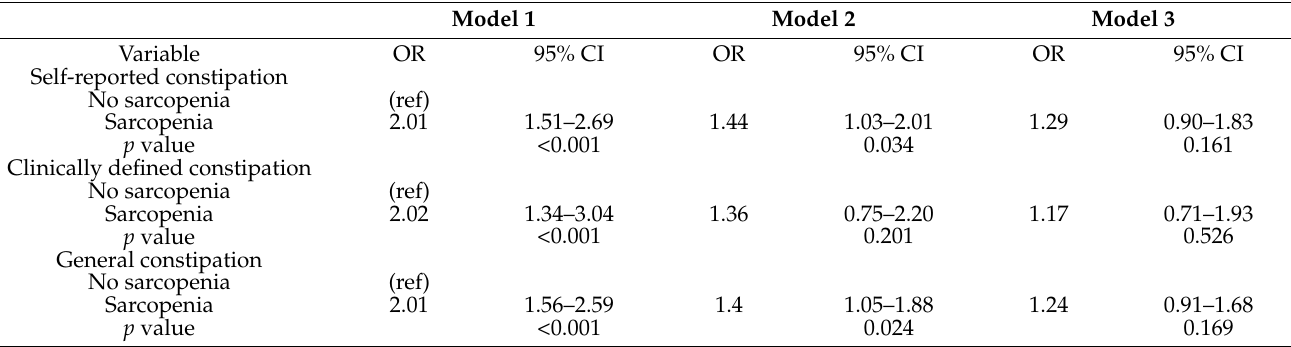
Table 4. Association of sarcopenia with constipation